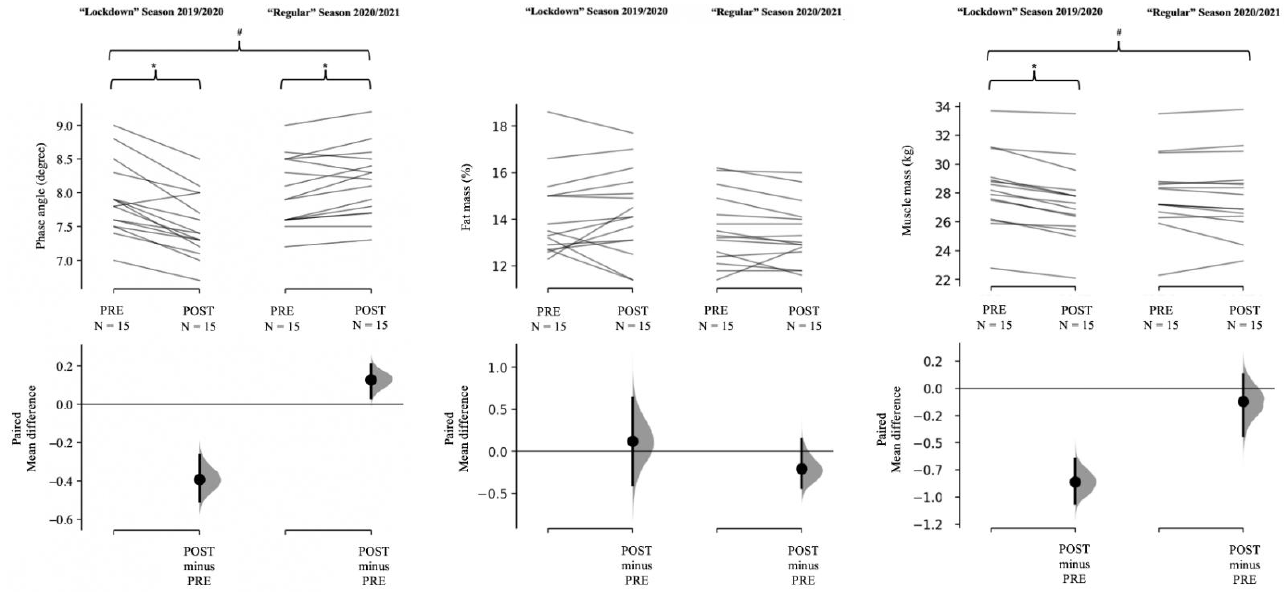
Figure 1. Paired mean differences for the comparisons are shown in the above Cumming estimation plots. Raw data are plotted on the upper axes; each paired set of observations is connected by a line. On the lower axes, each paired mean difference is plotted as a bootstrap sampling distribution. Mean differences are depicted as dots; 95% confidence intervals are indicated by the ends of the vertical error bars. * = significant ( p < 0.05) time effect; # = significant ( p < 0.05) condition by time interaction.